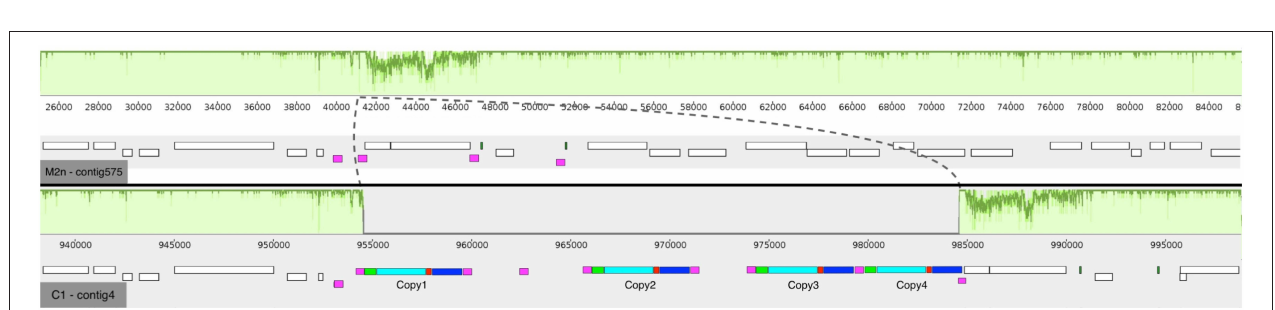
FIGURE 1 | Kinetic and metabolomic patterns of M2n and C1 strains during growth in glycerol and glucose. (A,B) Growth kinetics (filled symbols) and glycerol consumption (empty symbols) of M2n and C1 strains (A) ; growth kinetics (filled symbols), glucose consumption (empty symbols), and ethanol production (dashed lines) of M2n and C1 strains (B) . Data shown are the mean values of three replicates and relative standard errors were reported. (C,D) FTIR spectroscopy assessment of biochemical variation occurring during exponential (gray box) and stationary (red box) growth in glycerol (C) and glucose (D) . All significant different wavelengths ( p < 0.01) between M2n and C1 strains are reported as red dots. The percentages (%) of wavelengths of C1 spectrum significantly different from that of M2n are also reported.